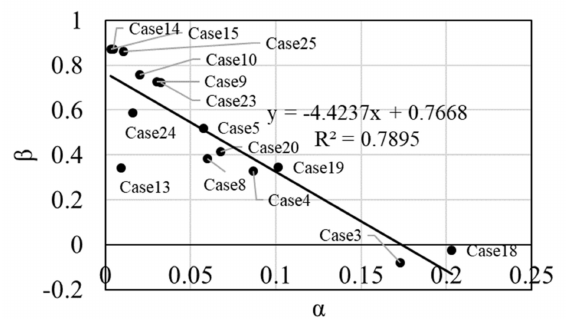
Figure 6. Relationship between α and β .